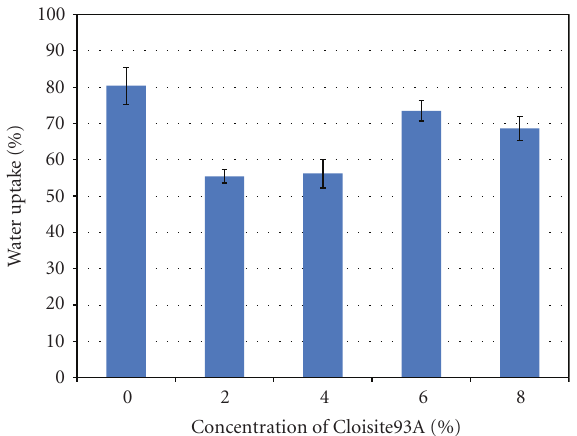
Figure 3: Water uptake values of sulfonated PVA membranes with varying concentrations of Cloisite 93A.